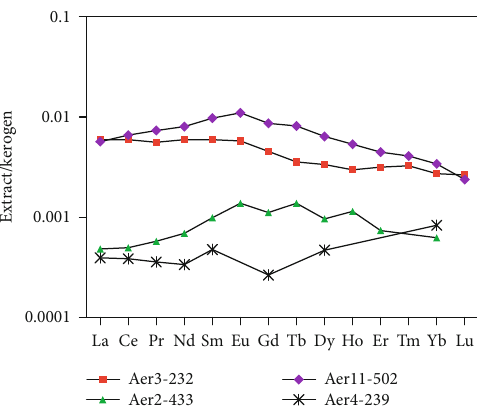
Figure 11: Rare earth elements in extract fraction of mudstones normalized to corresponding kerogen